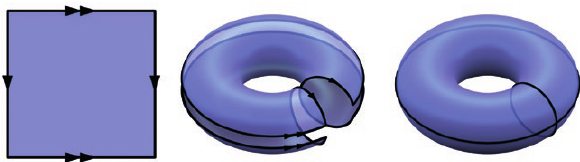
Figure 20. Gluing protocol for a torus from a rhombus. Figure courtesy Myfanwy